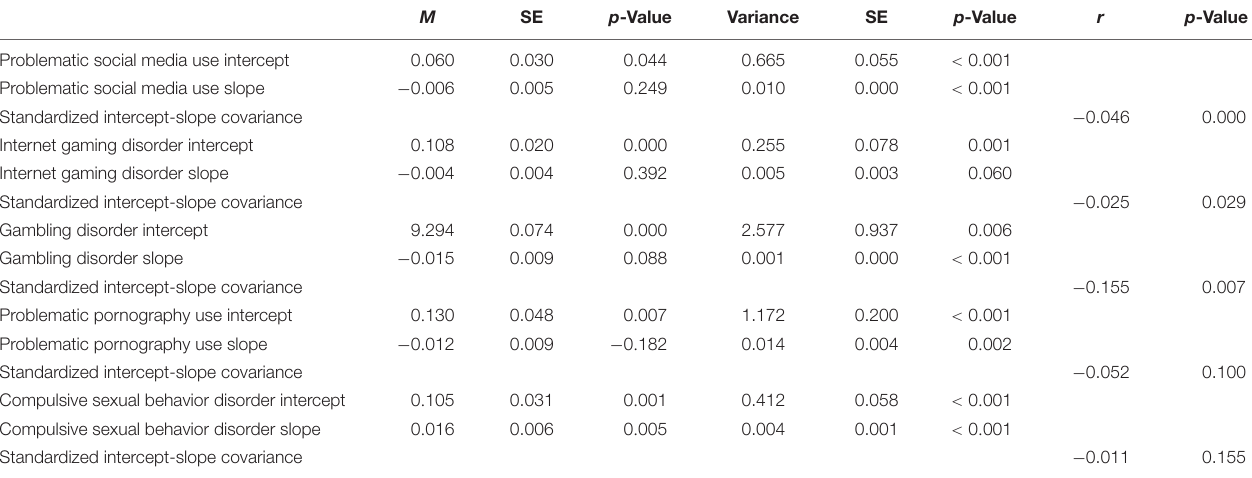
TABLE 4 | Growth curve